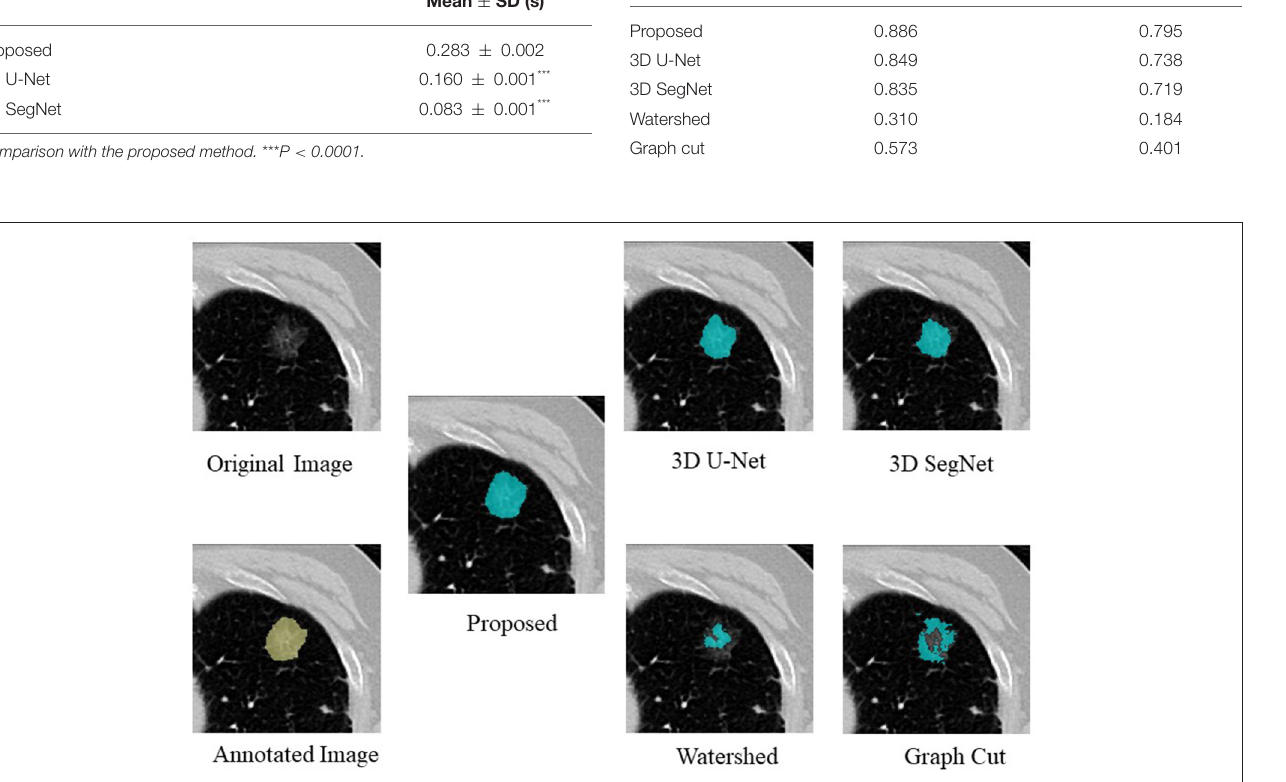
Frontiers in Artificial Intelligence |